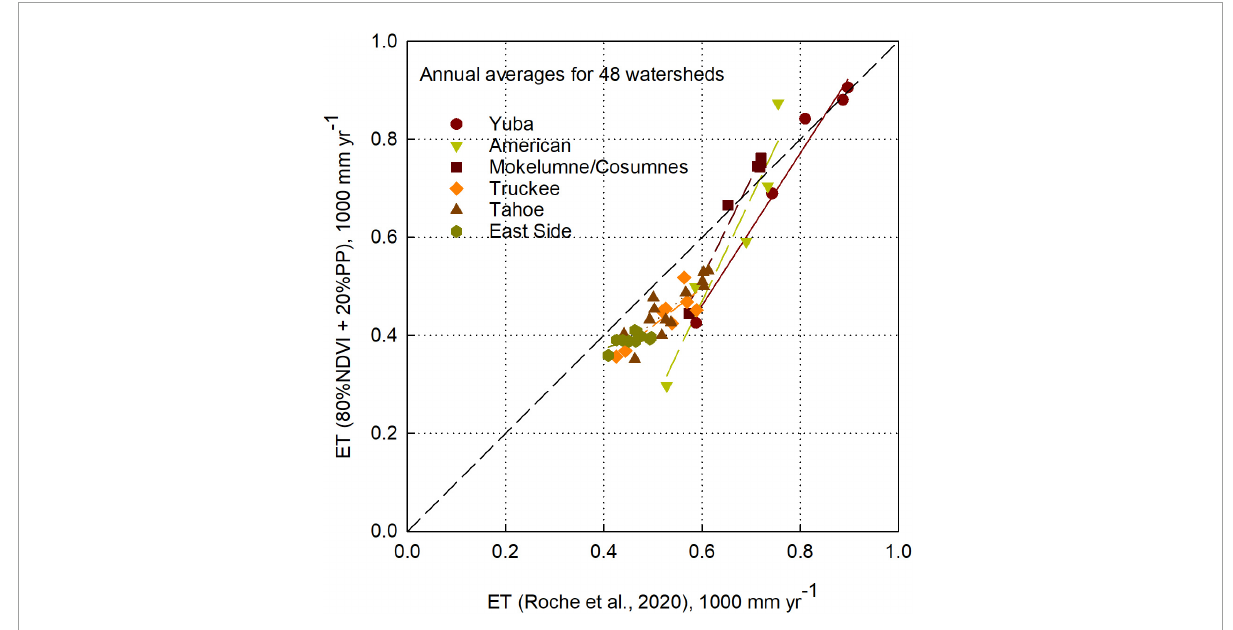
FIGURE9 ET comparison between Roche et al. (2020) regression and 0.8 NDVI + 0.2 PP weighting regression. The two approaches compare well for well-vegetated west-slope watersheds (Yuba, American, and Mokelumne/Cosumnes). The Roche et al. (2020) regression produces higher ET values for east-slope and more sparsely-vegetated watersheds (Truckee, Tahoe, East Side, and the Pyramid watershed in the American – lower most inverted